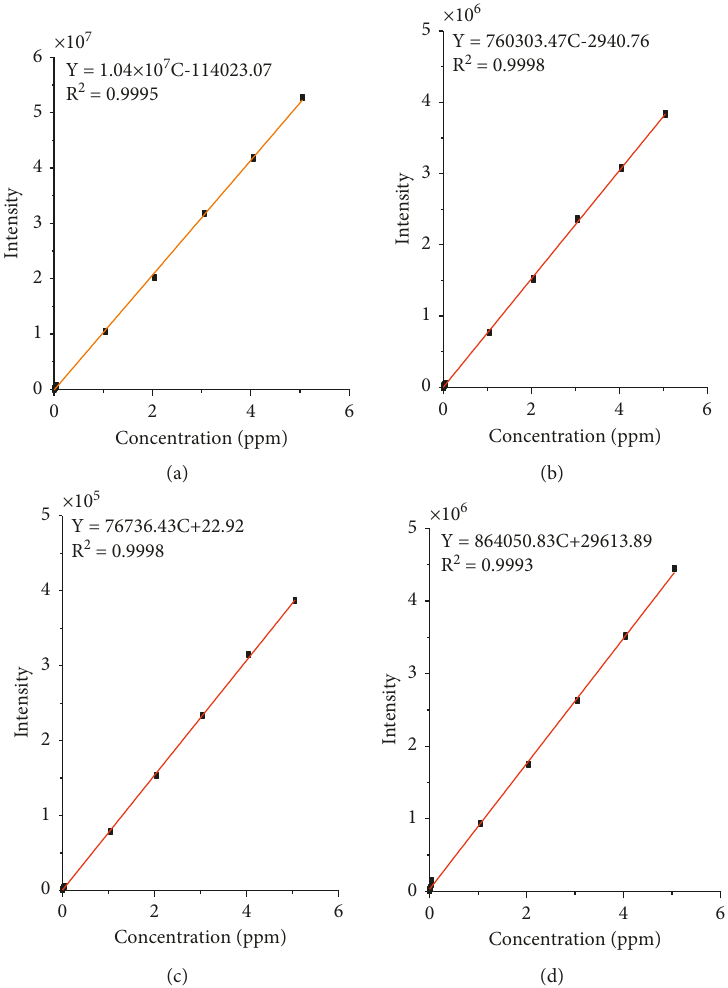
Figure 2: Calibration curves of the analyzed metals: manganese, cadmium, lead, and copper (A-D, resp.) with the concentration of 0.002, 0.004, 0.008, 0.016, 0.032, 0.05, 1.05, 2.05, 3.05, and